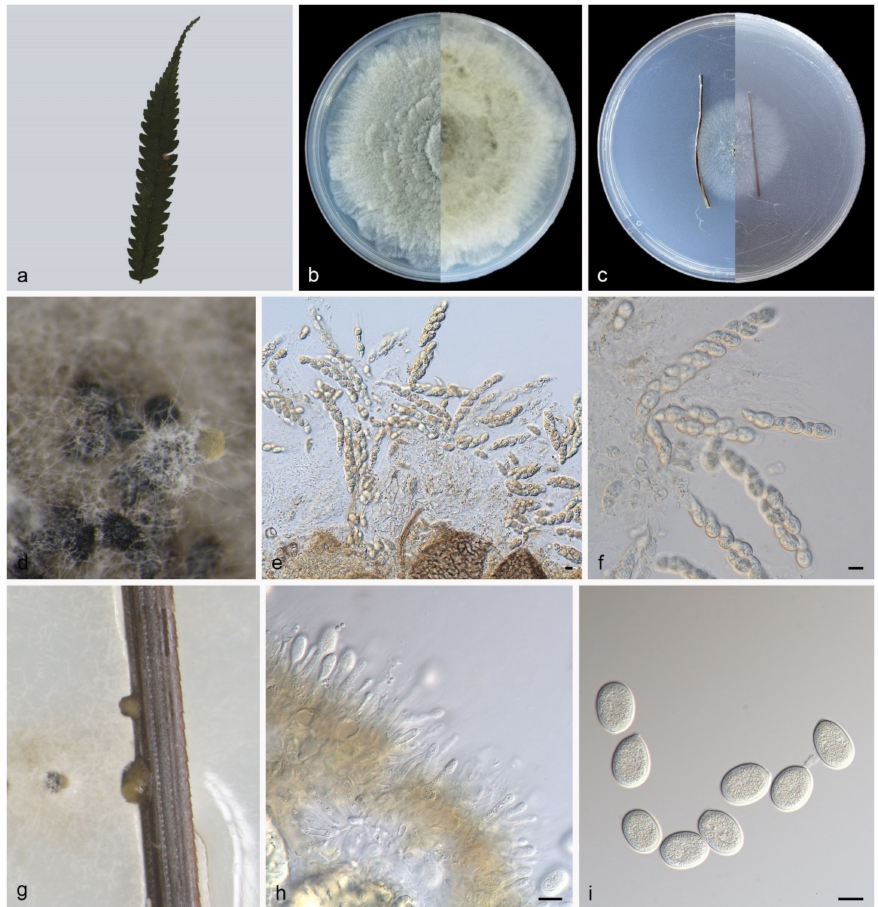
Figure 5. Pseudoplagiostoma alsophilae (holotype HMAS 352298). ( a ), leaves of host plant; ( b , c ), (left-above, right-reverse) after 15 days on PDA ( b ) and PNA ( c ); ( d , g ), colony overview; ( e , f ), asci and ascospores; ( h , i ), conidiogenous cells with conidia. Scale bars: ( e , f , h , i ), 10 µ